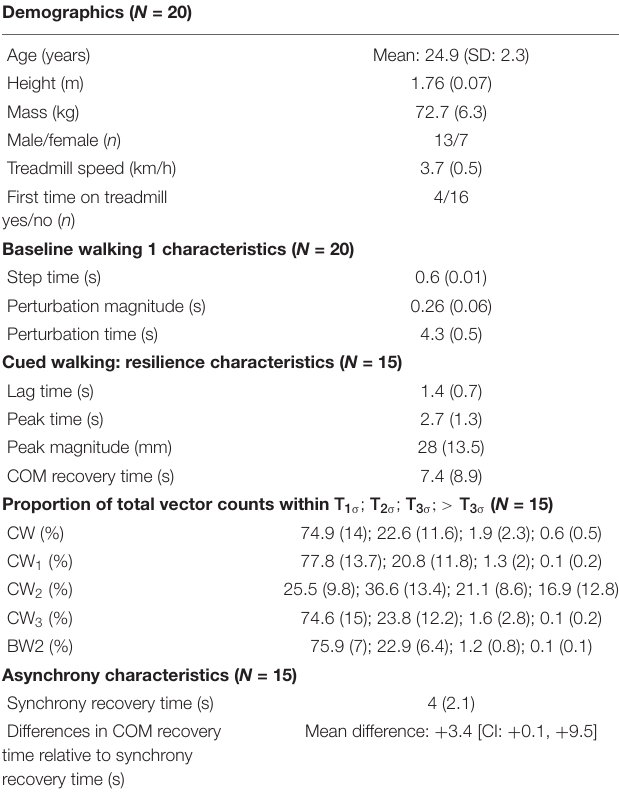
TABLE 1 | Demographics, walking, resilience, and asynchrony